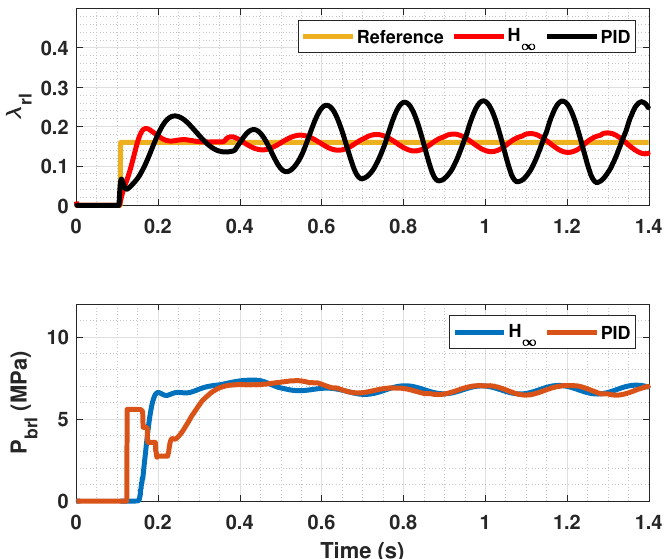
Figure 6. Rear wheels tire slip for front, reference tire slip and brake pressure for µ max =